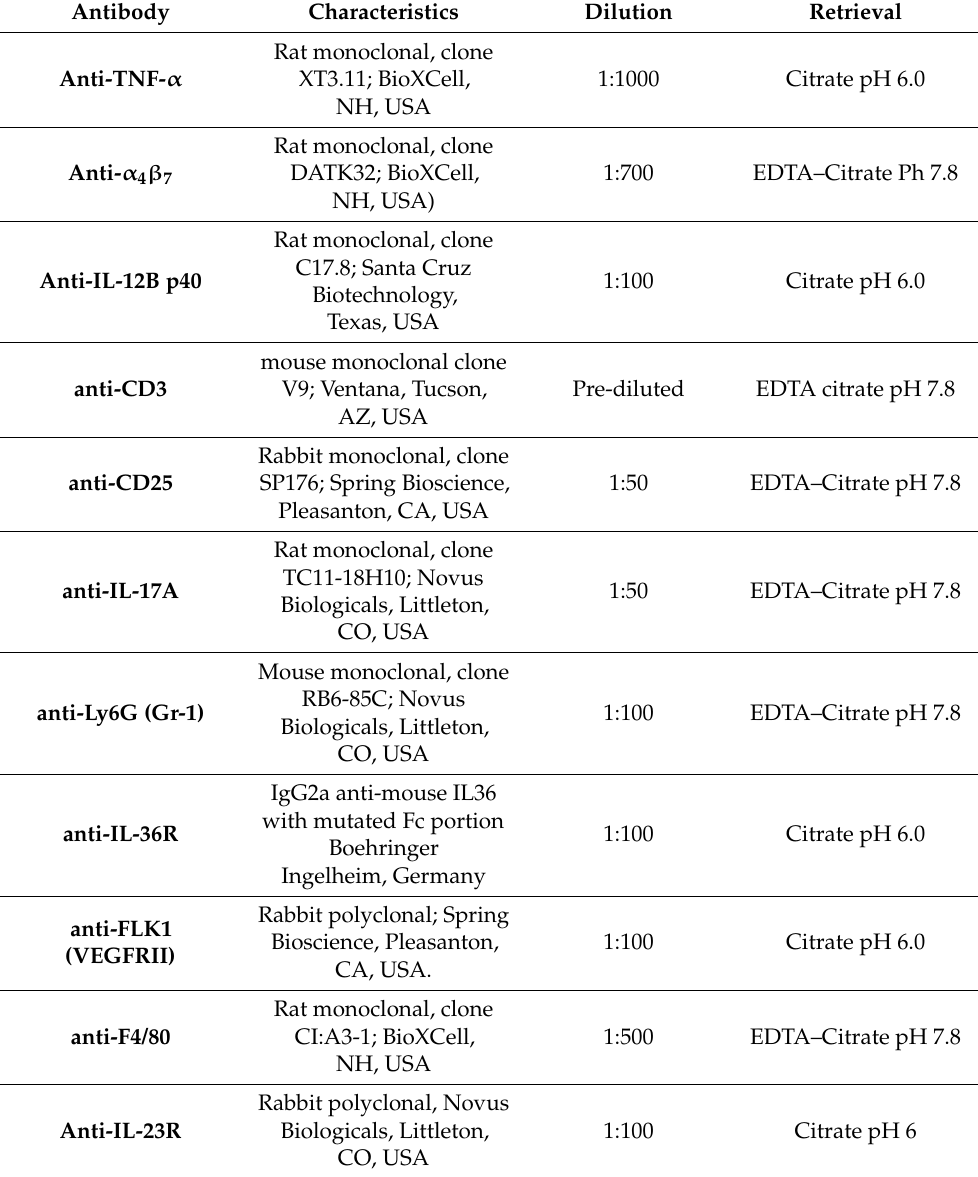
Table 2. List of antibodies used in the